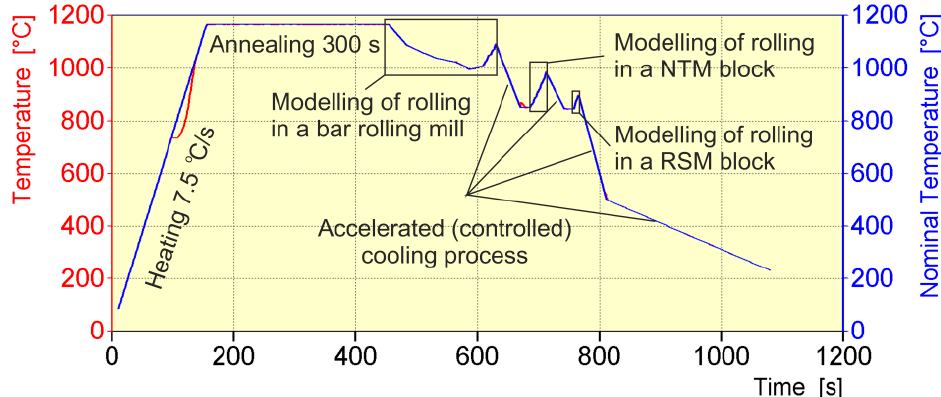
Figure 4. General model of thermo-mechanical treatment representing the entire rolling process of a 20MnB4 steel wire rod with a diameter of 5.5